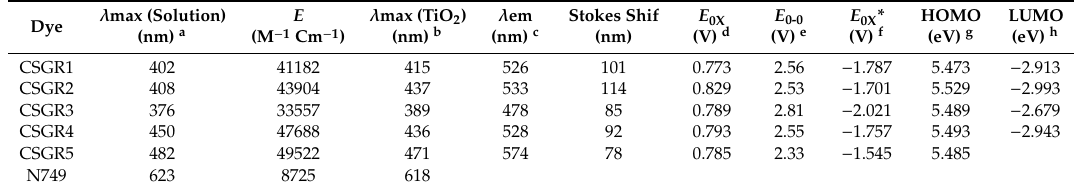
Figure 3. ( a ) UV-visible Spectral analysis of CSGR1-5 in DMF solution and ( b ) on TiO 2 thin film. Table 1. Photophysical and electrochemical data of CSGR1-5 dyes.